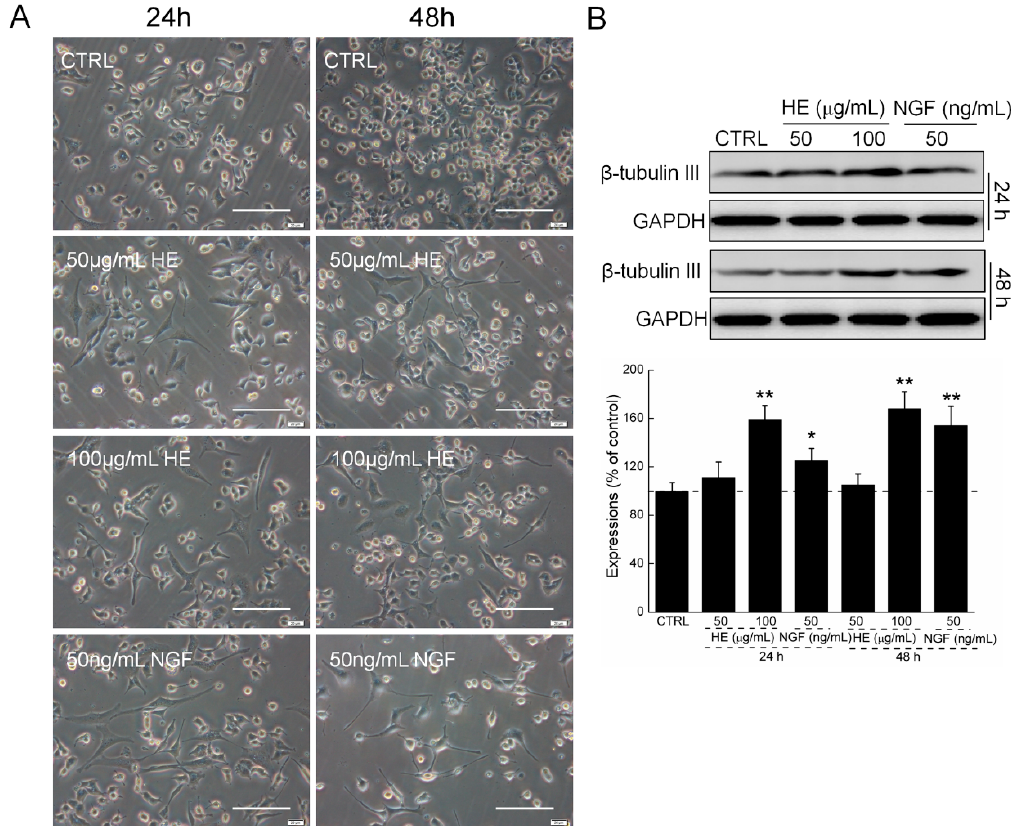
Figure 1. ( A ) HE and NGF induced PC12 cell differentiation determined by inverted microscope. Scale bar: 100 µm. ( n = 6); ( B ) HE and NGF enhanced the expressions of β -tubulin III in PC12 cells. Data are expressed as mean ± SD ( n = 6). * p < 0.05 and ** p < 0.01 vs. CTRL, HE: Hericium erinaceus aqueous extract; NGF: Nerve growth factor; CTRL: Non-treated cells.